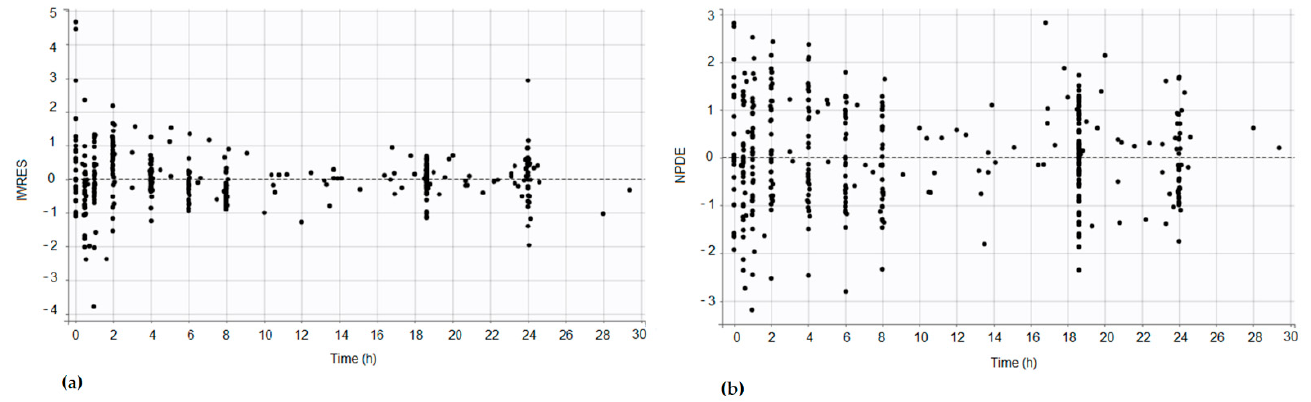
Figure 3. ( a ) Individual residual error distribution (IWRES); ( b ) NPDE.